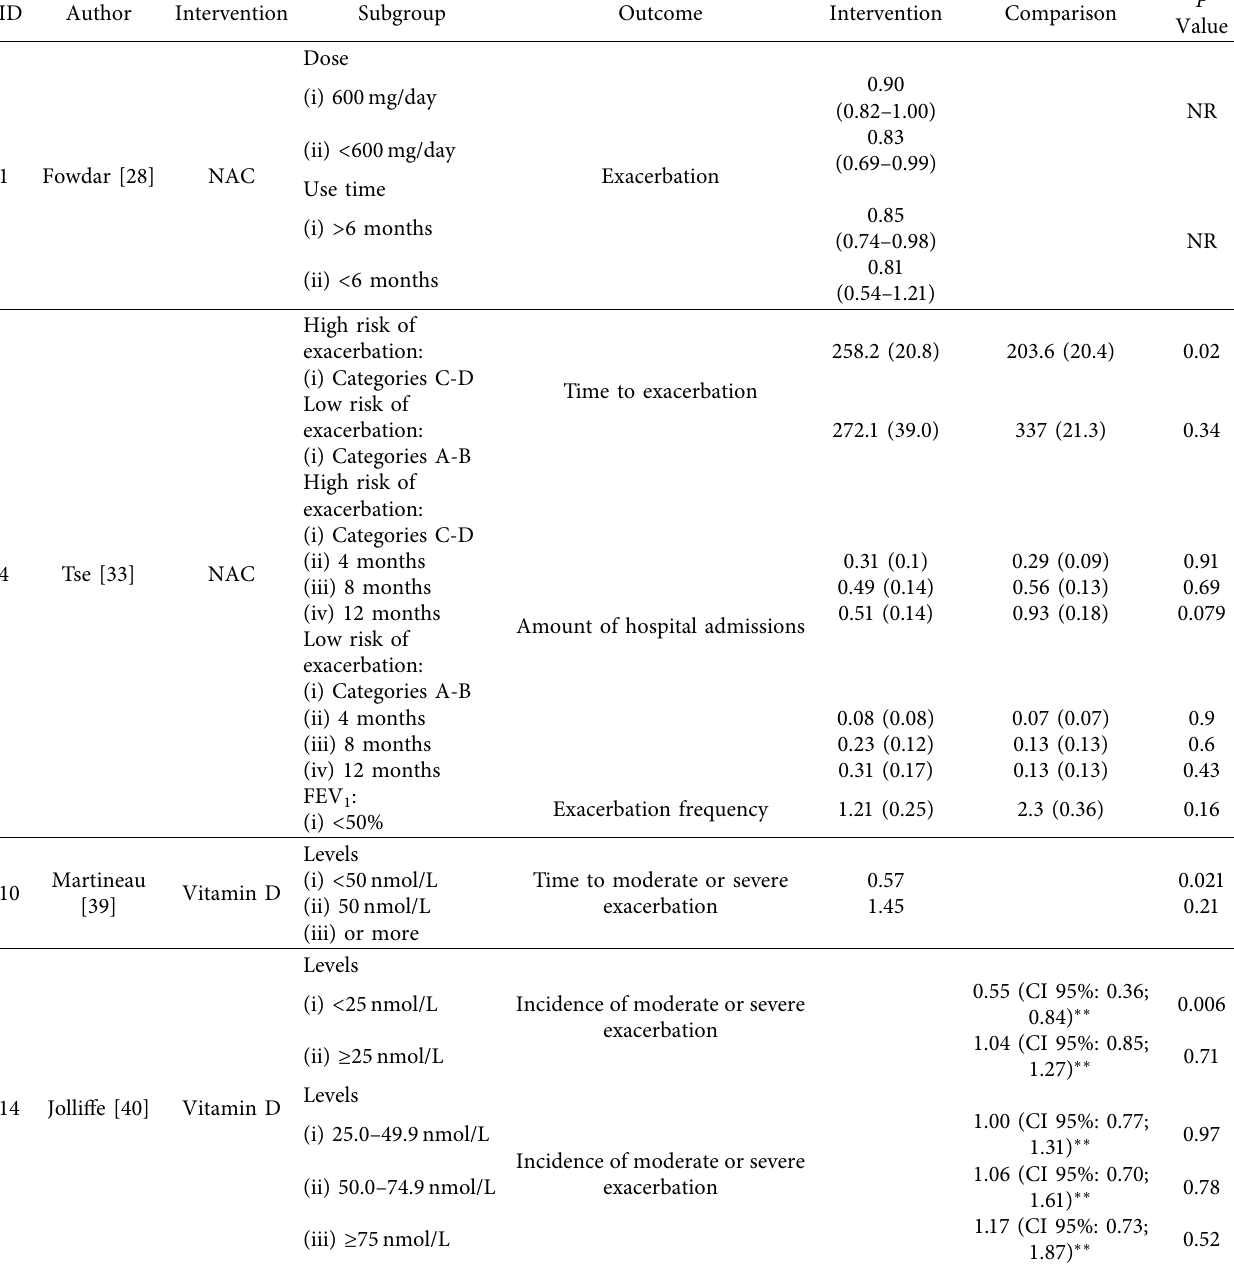
Table 4: Outcomes by subgroups of